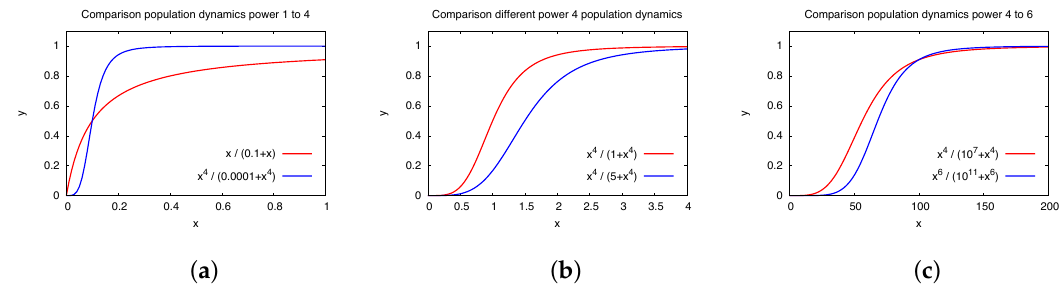
Figure A9. Population dynamics coefficient structure for the choice of different parameters. Plotting y = f ( x ) = x a for different choices of a , b . Model coefficient comparisons of possible factors: x a + b Comparison of functions with factor a = 1, 4 and 6 (cf. Appendix I). Obviously, power 4 enables sharper transitions then power 1, but power 6 does not cause further big changes. ( a ) Comparison of a = 1 and a = 4, ( b ) comparison for case a = 4 using different values of b , ( c ) comparison case a = 4 and a =